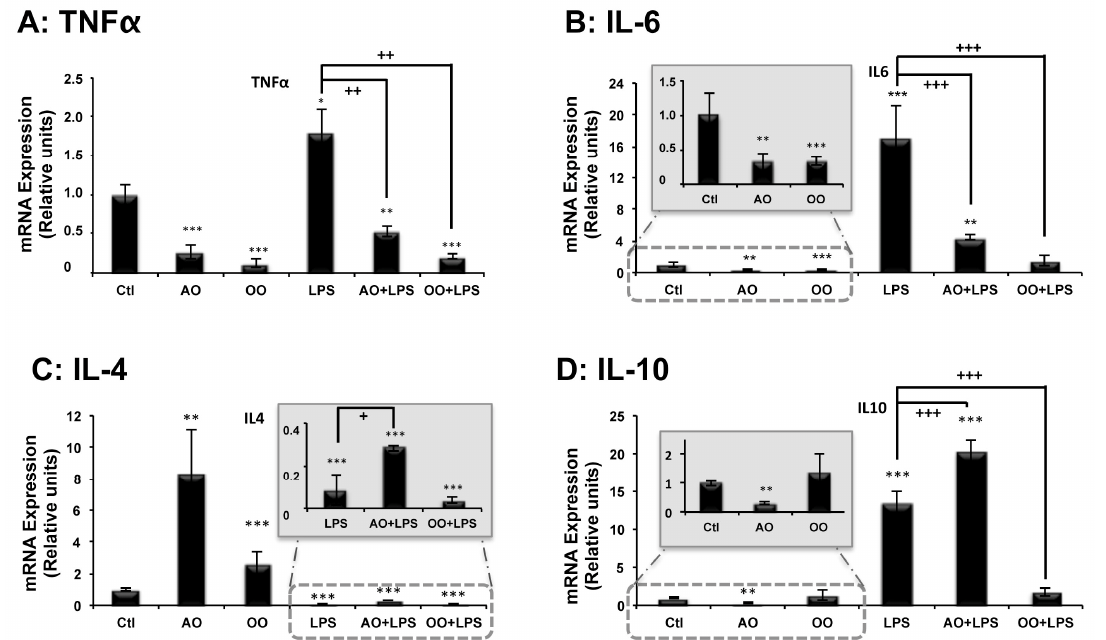
Figure 3. Effects of argan oil and olive oil on LPS-induced disturbances in proinflammatory Tumor necrosis factor α ( Tnf- α ) ( A ) and Interleukin-6 ( Il-6 ) ( B ) and anti-inflammatory Interleukin-4 ( Il-4 ) ( C ) and Interleukin-10 ( Il-10 ) ( D ) cytokines’ gene expressions, in mouse liver tissue. Mice received, for 25 days, a standard chow (control: Ctl); a standard chow supplemented with 6% ( w/w ) argan oil (AO) or a standard chow supplemented with 6% ( w/w ) olive oil (OO). Sixteen hours before euthanasia, separate groups of animals, given control, AO and OO-supplemented diets underwent an intraperitoneal injection of 100 μ g LPS (LPS, AO + LPS and OO + LPS groups, respectively). Total RNAs isolated from mouse liver were amplified by RT-qPCR, using specific primers. All real-time PCR reactions were performed in duplicate. All values represent means ± SEM ( n = 5 per group) and are normalized to the control. Statistical significance of higher mean signal intensity (*** p < 0.001, ** p < 0.01, * p < 0.05) compared to control and ( +++ p < 0.001, ++ p < 0.01, + p < 0.05) compared to LPS.